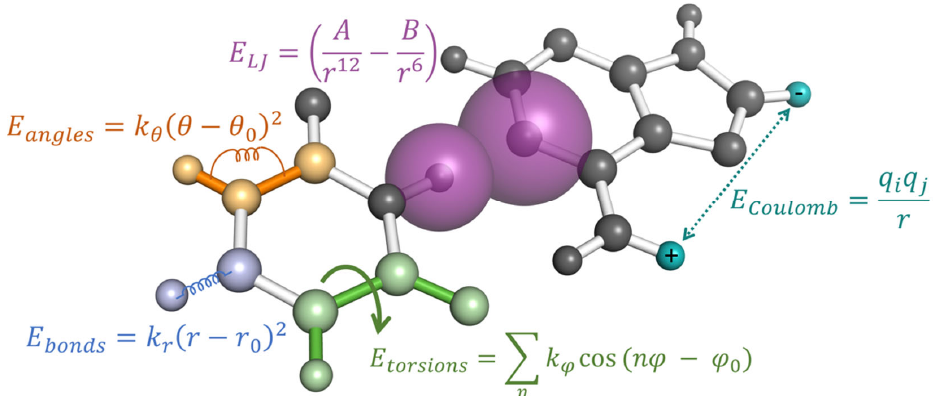
Figure 3. The potential energy of an MD simulation is calculated using pairwise additive energies as a function of their geometric distances and angles relative to other atoms. Each type of interaction is represented by a single example in this figure, while the total energy of the system is the sum over all bonded terms ( E bonds , E angles , and E torsions ) and non-bonded terms ( E LJ and E Coulomb